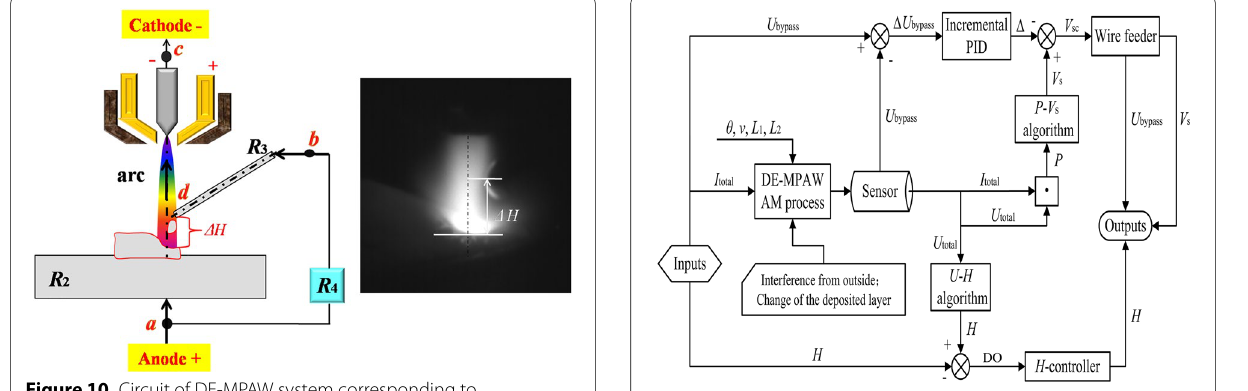
Figure 11 Structure of proposed DE-MPAW control